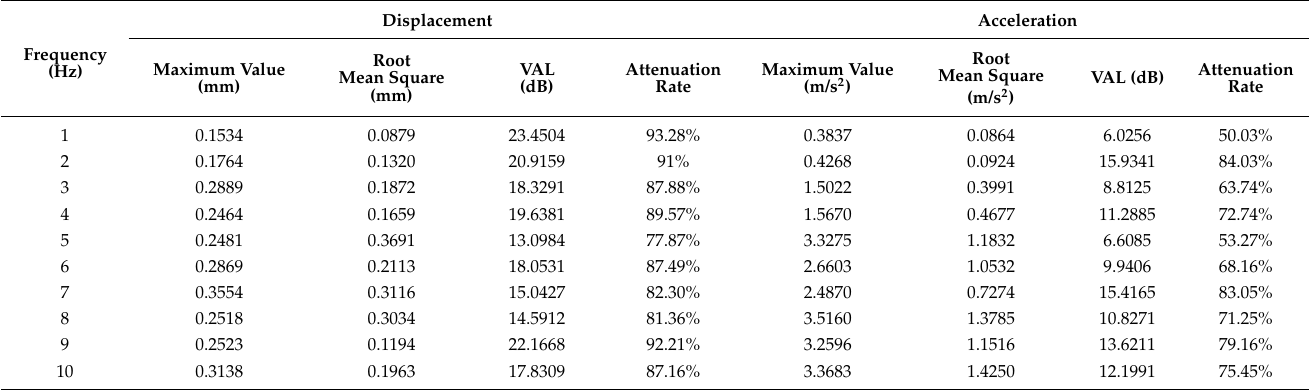
Table 5. Vibration response of the pipeline with fuzzy–PID control.